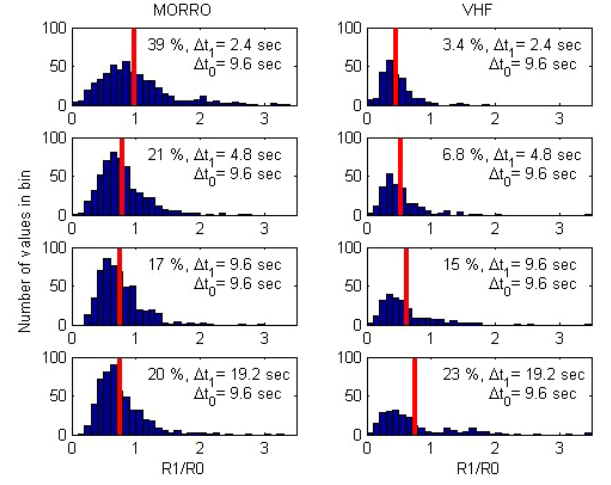
Figure 5. The distribution of the ratio R1/R0 for the MORRO radar and the EISCAT VHF radar. The percentage values refer to the fraction which has R1/R0>1, indicating onset overshoots. The included ratios are for cases where the PMSE signal strength R0 is at least twice that of the background strength. The sampling time interval for R0 is (cid:49)t 0 = 9.6s for all cases, while (cid:49)t 1 is given values from 2.4 to 19.2s as shown in the figures. The heater is on for 48s. The average values of R1/R0 are indicated by the vertical red lines. For a case of (cid:49)t 1 = 1.2s (not shown) the percentages for MORRO and VHF with R1/R0>0 are 40 and 2.1%